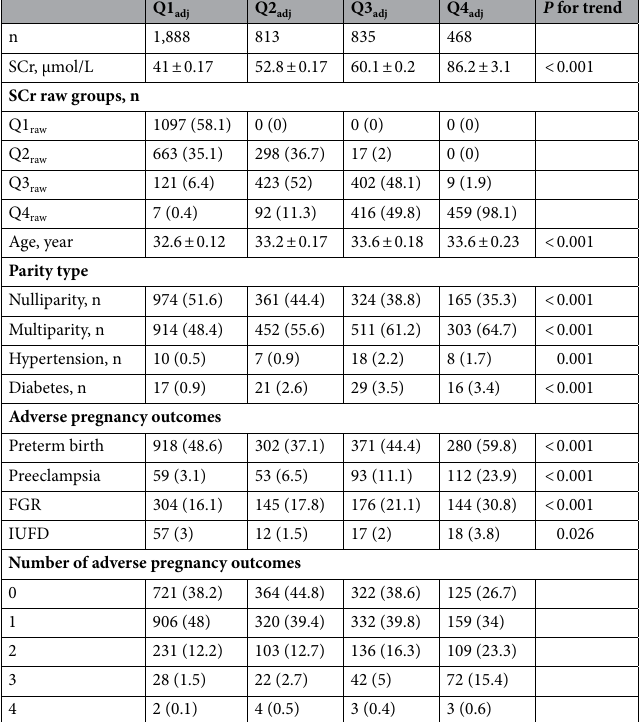
Table 1. Medical and biochemical characteristics based on SCr groups categorized by the gestational age- specific serum creatinine distribution made by Harel and colleagues 16 . SCr serum creatinine, FGR fetal growth retardation, IUFD intrauterine fetal demise.